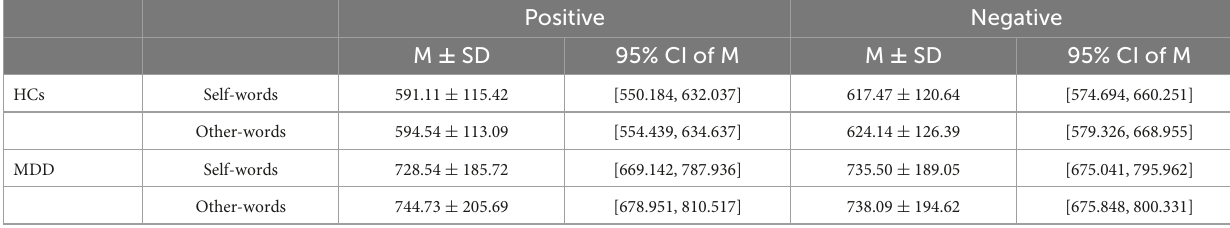
TABLE 2 RTs of MDD and HCs in